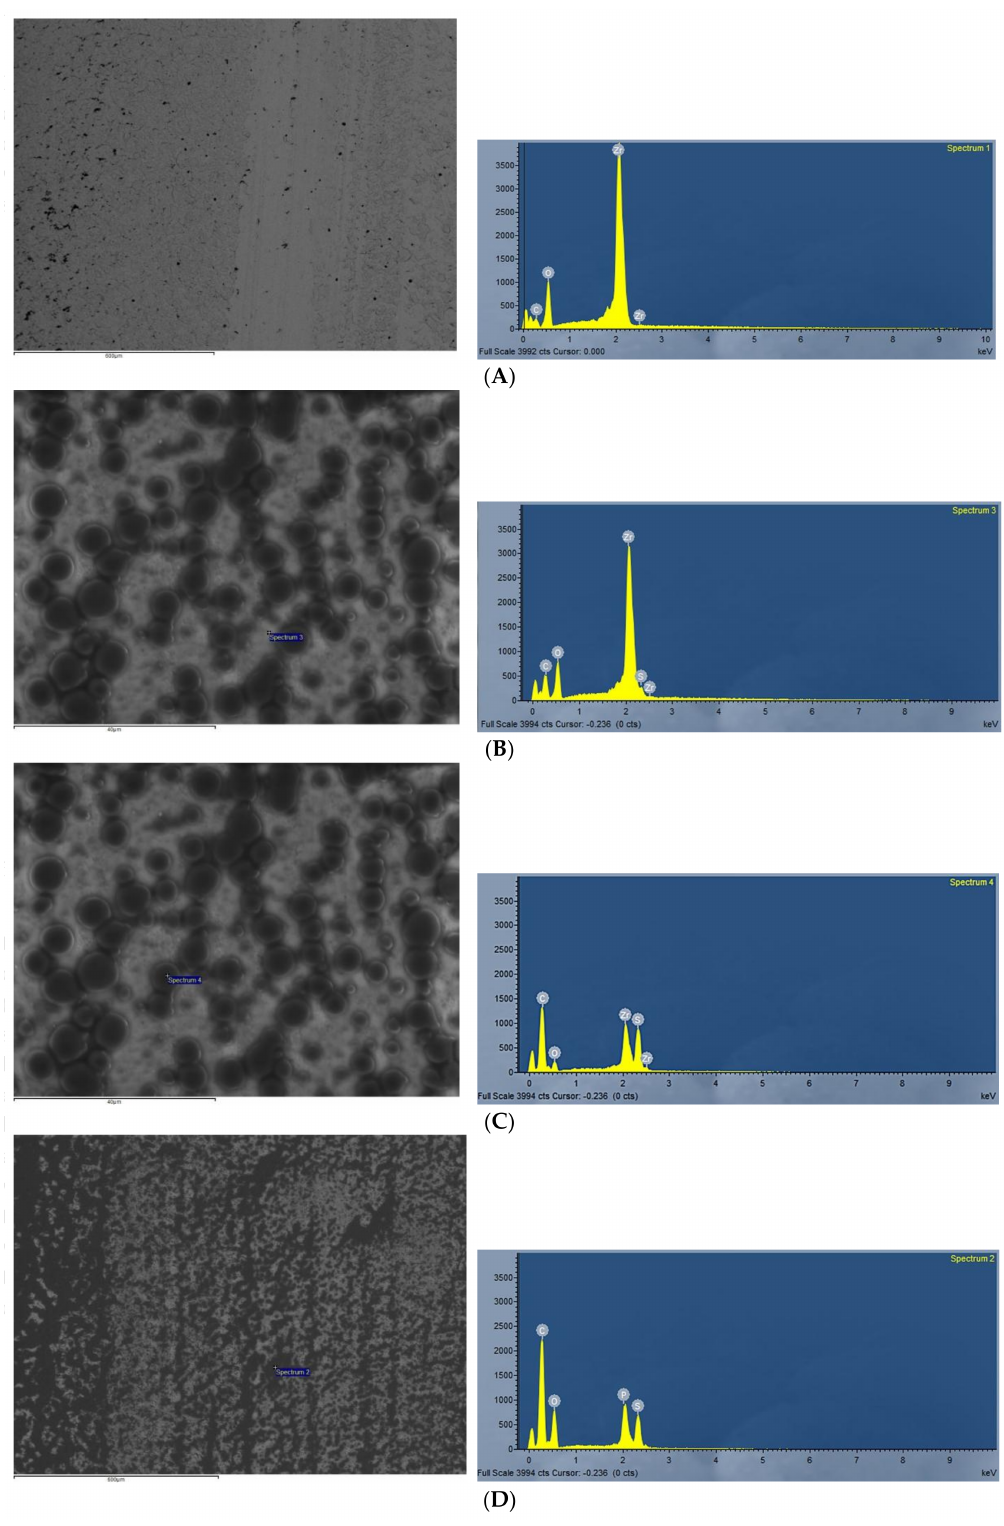
Figure 2. SEM of primer-treated Y-TZP samples and spectra presented by energy dispersive X-ray spectroscopy. ( A ) Control sample indicating high peaks of zirconium, oxygen, and carbon; ( B ) MV4-treated surface, with a thin film coverage evidenced by high peaks of zirconium; Darker spots seen on ( C ) (spectrum 4) show a higher concentration of sulfur and carbon covering the zirconium surface. ( D ) MV7-treated surface, where high peaks of carbon, phosphorous, and sulfur are evidenced in the darker areas (spectrum 2), compatible with high concentration of both monomers (carbon and phosphorous from MDP and carbon and sulfur from